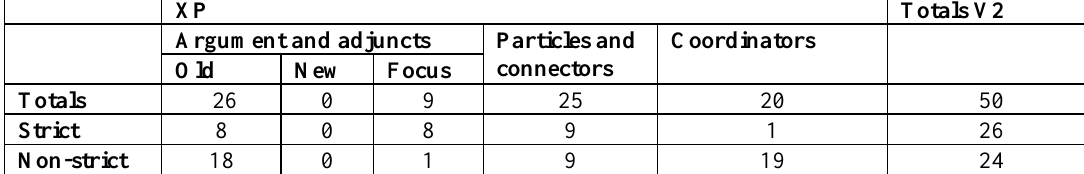
Table 4. Informational value of XPs in Queste narration XP Totals